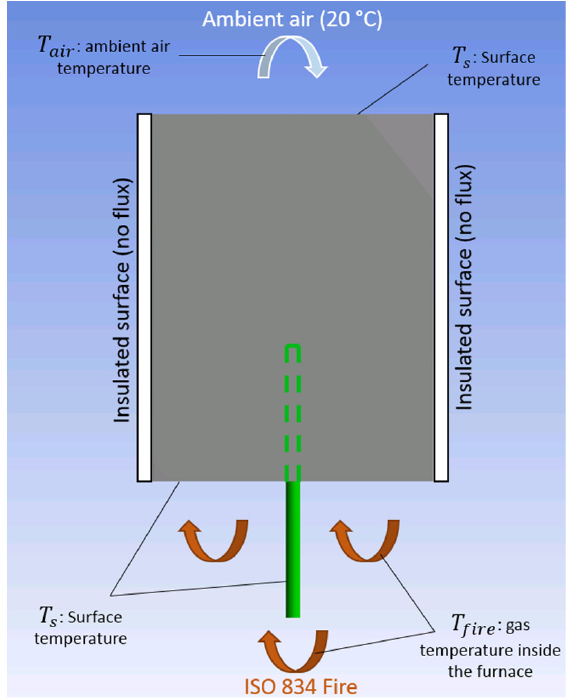
Figure 4. Boundary conditions applied in the 3D heat transfer analysis for anchors directly exposed to fire [22].